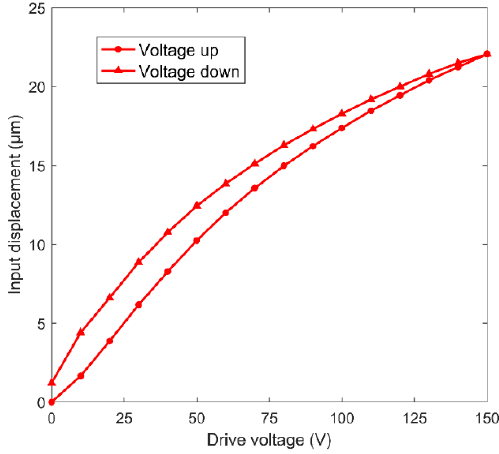
Figure 11. Input displacement versus the drive voltage.